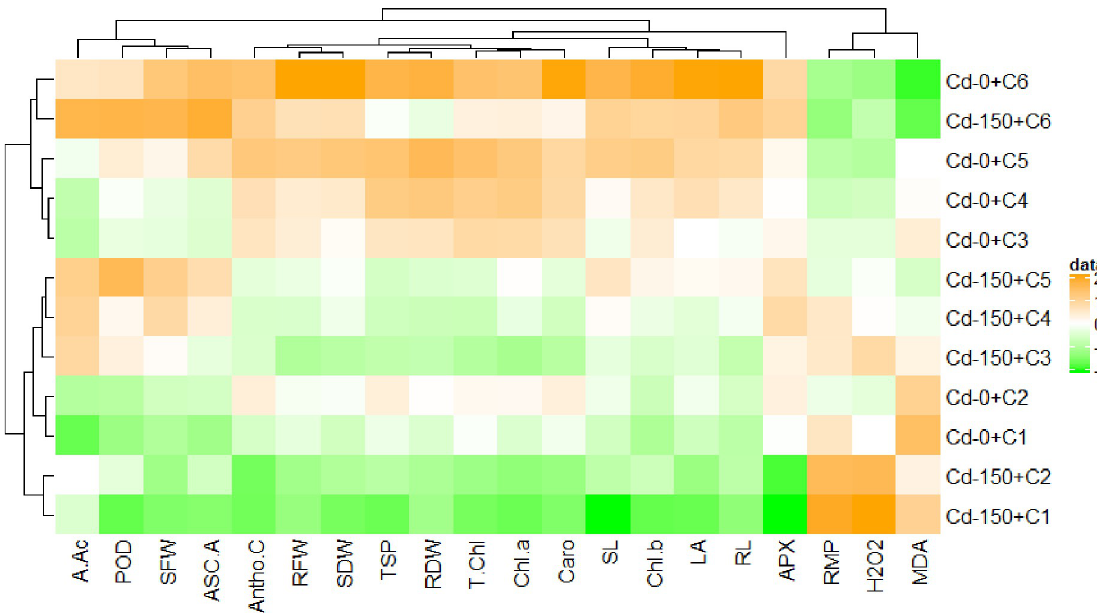
Fig 5. Clustered heatmap representing the effect of Cd and Ca (C1- 0 m M , C2- 0.5 m M , C3- 1 m M , C4- 2.5 m M , C5- 5 m M , C6- 10 m M ) treatments on different studied traits. Abbreviations are given at start of